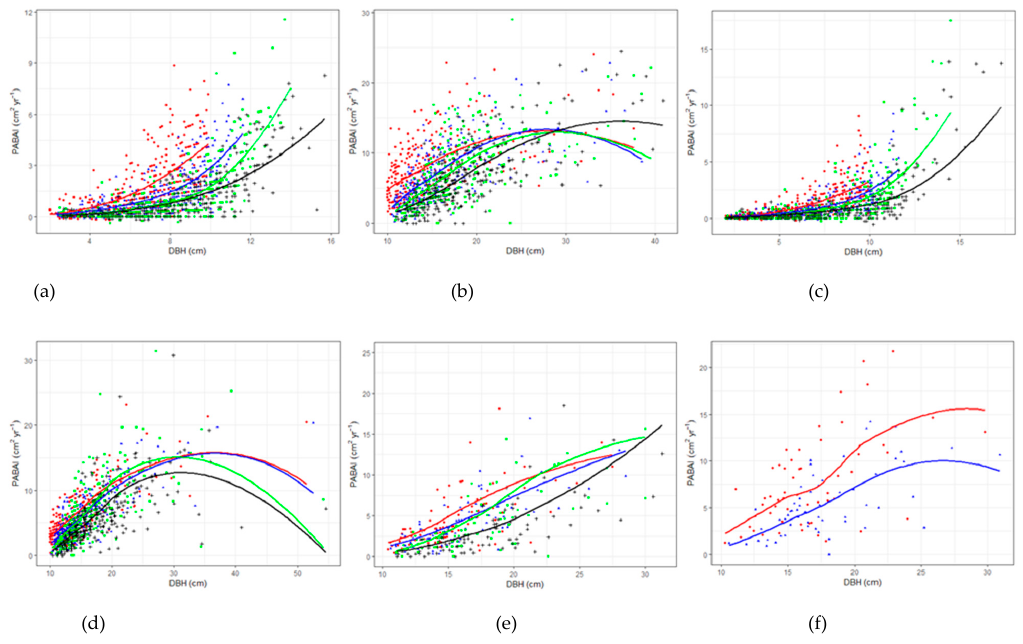
Figure A3. Predicted periodic annual basal area increment versus DBH using the fixed effects parameters of the equation with the single CI (Equation 8) for ( a ) small interior Douglas fir in Block C; ( b ) large interior Douglas-fir in Block C; ( c ) small interior Douglas fir in Block D; ( d ) large interior Douglas-fir in Block D; ( e ) large spruce in Block D; and ( f ) large PL in Block D. The red, blue, green, and black lines represent predicted PABAI for 1993–1997, 1997–2004, 2004–2008, and 2008–2013 growth periods, respectively. The red, blue, green, and black symbols represent the measured PABAI for the same periods.